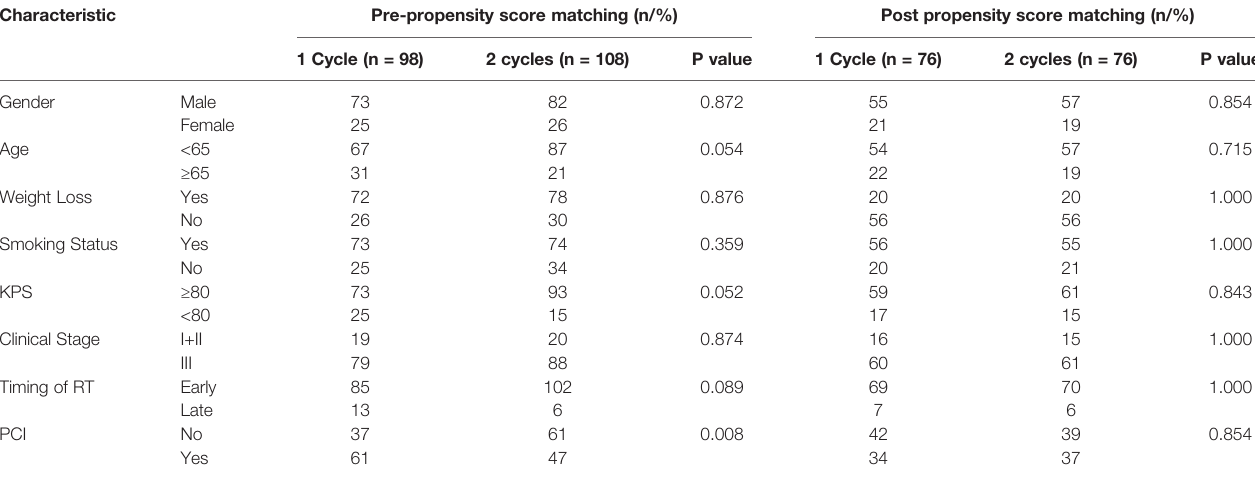
TABLE 1 | Clinical characteristics of patients in 1 cycle and 2 cycles groups before and after propensity score matching. Characteristic Pre-propensity score matching